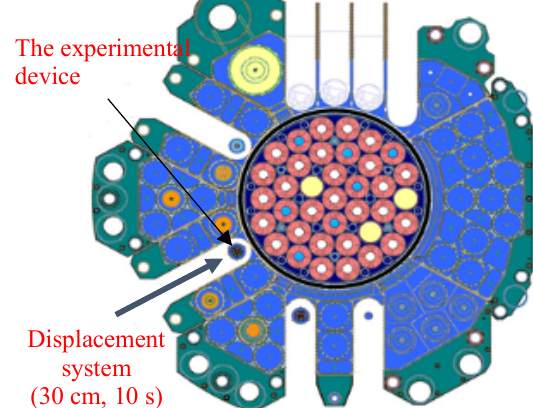
Fig. 1. The Jules Horowitz reactor core and reflector; the position of the experimental device: the JHR reflector on the displacement system.